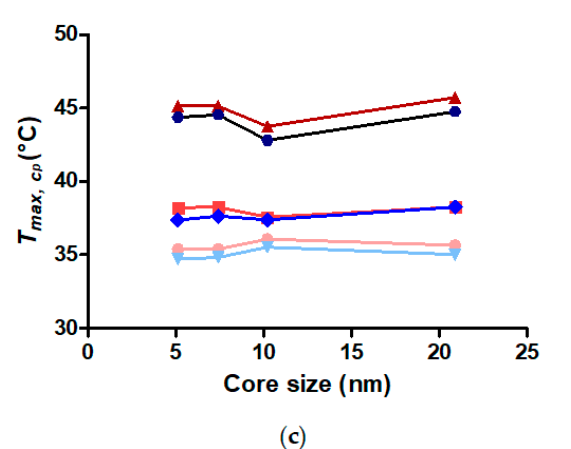
Figure 6. DSC transition peak analysis. ( a ) Overlay of DSC endotherms of free polymer (dark blue), FeOx-5 (light orange), FeOx-7 (orange), FeOx-10 (red) and FeOx-21 (dark red) at a polymer concentration of 1 g L − 1 ; ( b ) Fraction of the total transition enthalpy of each fitted transition peak for core-shell nanoparticles. All DSC curves were fitted with three Gaussian curves. The enthalpy of each fitted Gaussian was normalized by the total enthalpy of the transition to obtain the plotted fractions. Each bar presents the contribution to the total peak area at a polymer concentration of 1 g L − 1 . Contributions of the lowest (green), intermediate (blue) and highest (red) temperature transitions were assigned to the inner, intermediate and outer shell, respectively. Heating curves are left and cooling curves are right, with the latter marked by *; ( c ) Temperature of maximum c p ( T max , c each deconvoluted transition peak at a polymer concentration of 1 g L − 1 .